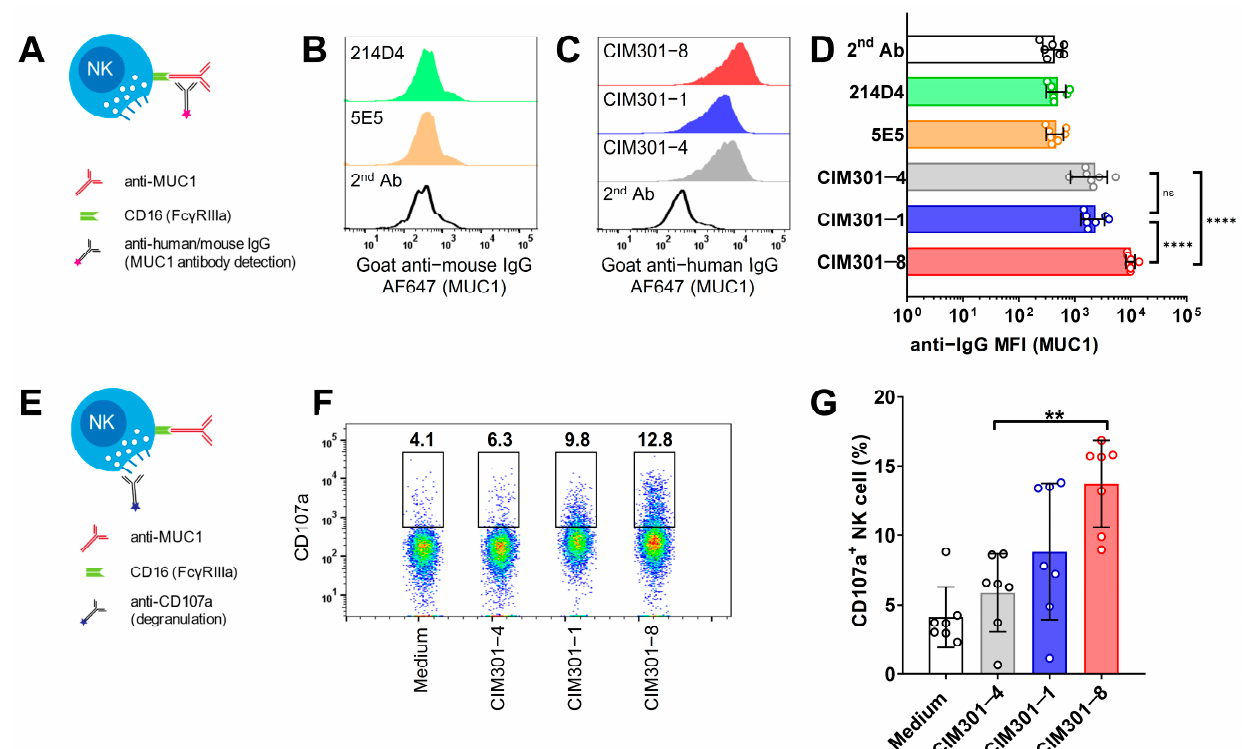
Figure 2. Humanized anti-MUC1 antibodies bind to CD16 on NK cells and induce degranulation. ( A ) Schematic overview outlining the detection of mAb binding via their Fc tail to the Fc γ RIIIa receptor (CD16) expressed on NK cells. ( B ) Binding of murine anti-MUC1 antibodies on primary human NK cells. Histograms show expression levels of the labeled anti-mouse IgG secondary antibodies used to detect MUC1 antibody binding. ( C ) Binding of humanized anti-MUC1 antibodies on primary NK cells. Experiment as in B, but using humanized anti-MUC1 antibodies, detected using anti-human IgG secondary antibodies. ( D ) Quantification of anti-MUC1 antibody binding to primary human NK cells. ( E ) Scheme depicting analysis of NK cell degranulation. ( F ) Flow cytometric analysis of NK cell degranulation following 4 h incubation of primary human NK cells with anti-MUC1 antibodies. One representative sample is shown with numbers indicating frequencies of cells within the indicated gate. ( G ) Quantification of the degranulation assay shown in ( F ). Bars in ( D ) and ( G ) show mean ± SD with individual data points as dots. Pooled data from seven independent experiments with different donors performed at different time points. Statistical analysis using one-way ANOVA plus Tukey’s multiple comparisons test. In ( D ), only biologically relevant comparisons were made. Not significant (n.s.); p < 0.01 (**); p < 0.0001 (****).